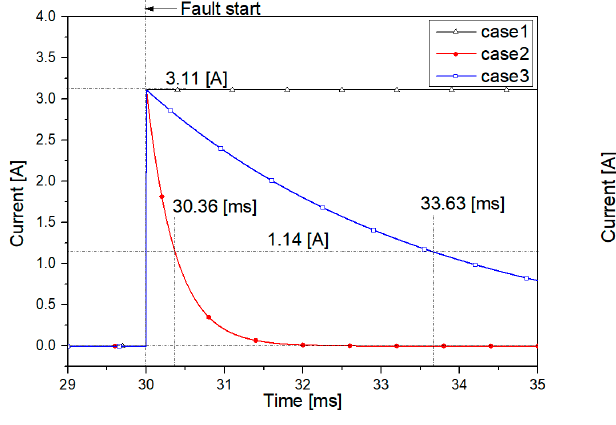
Figure 12. Fault current for a fault resistance of 10 Ω ( a ) Resistance used in mid ‐ point ground was 100 Ω ; ( b ) Resistance used in mid ‐ point ground was 1000 Ω .